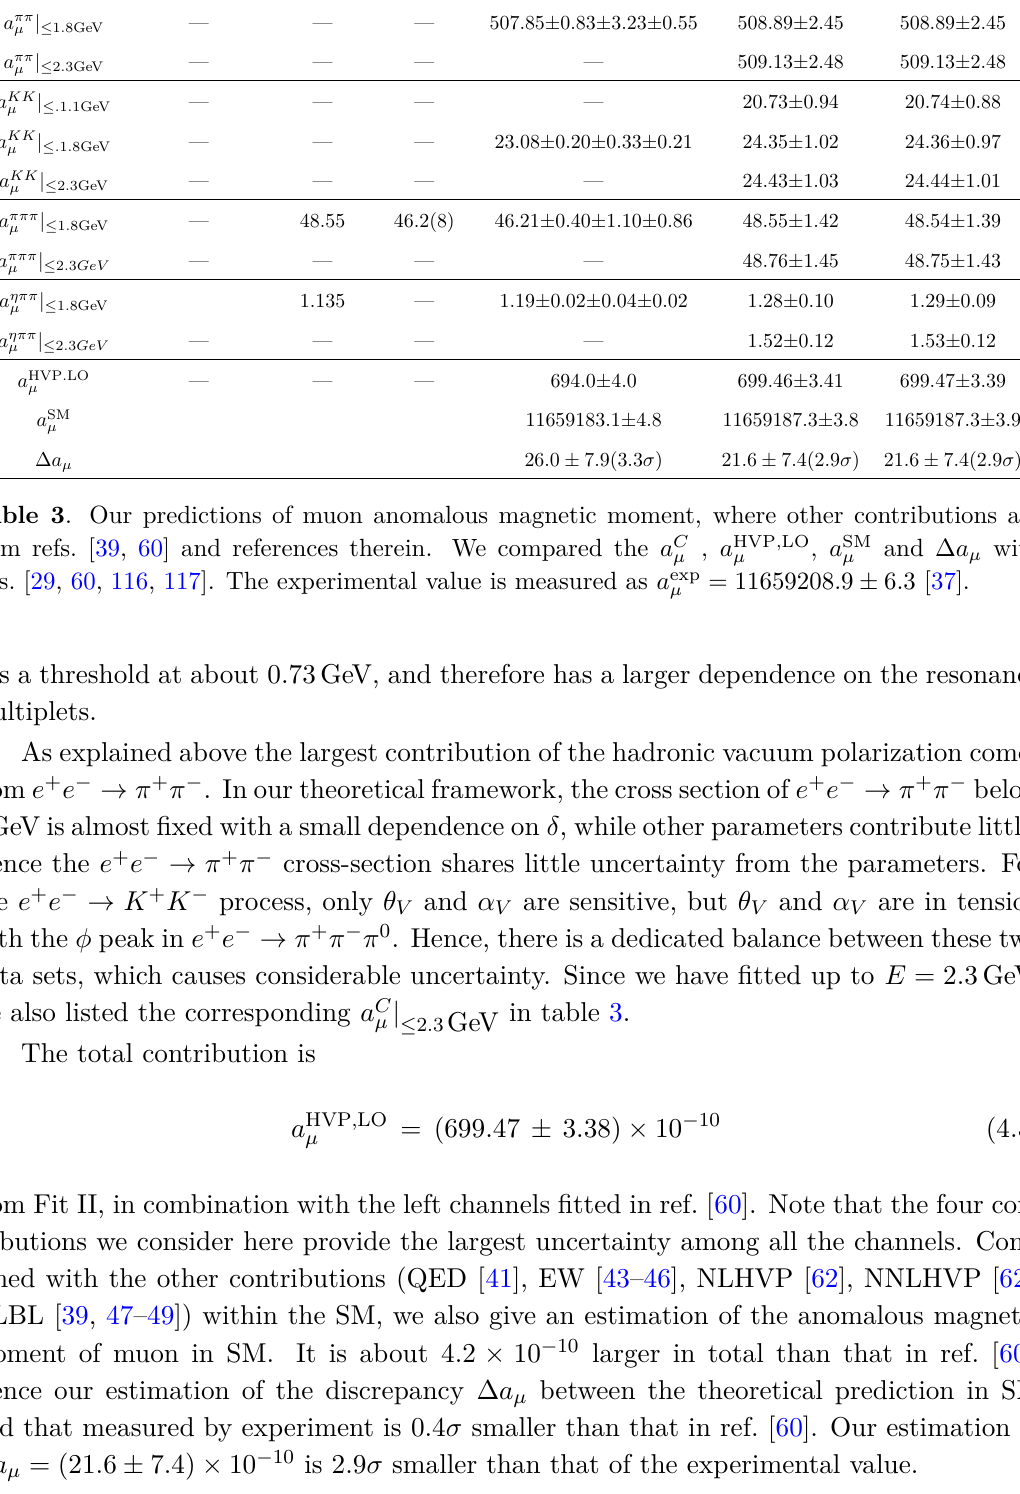
, a HVP , LO , a SM and ∆ a µ with µ µ µ = 11659208 . 9 ± 6 . 3 µ